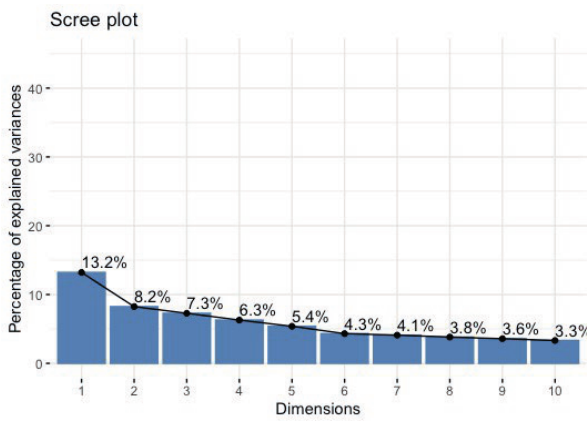
Figure 2. Multiple correspondence analysis (MCA) based on 30 loci studied on date palm trees.